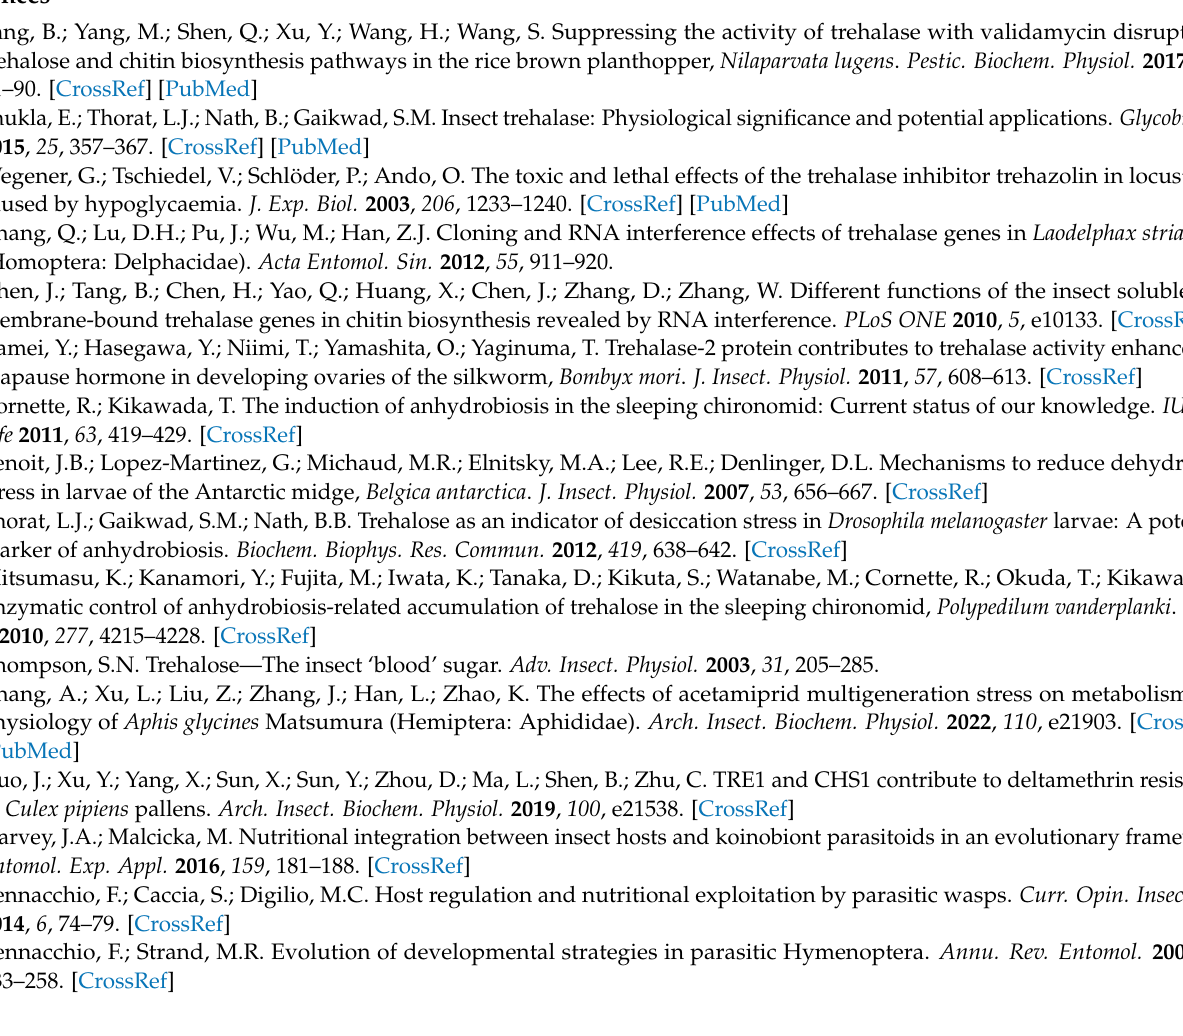
Table S3: Oligonucleotide templates used to synthesize siRNA. Table S4: Statistical values of ANOVA in the present